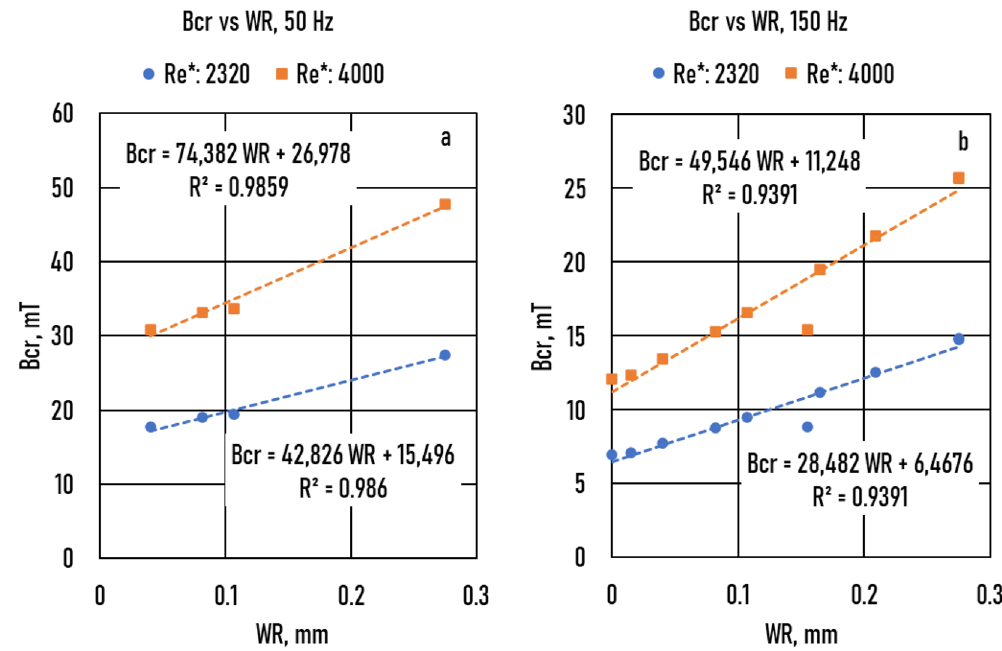
Figure 8. The critical magnetic induction ( Bcr ) as a function of wall roughness ( WR ) for real Reynolds numbers ( Re* ), ( a ): f = 50 Hz, ( b ): f = 150 Hz.